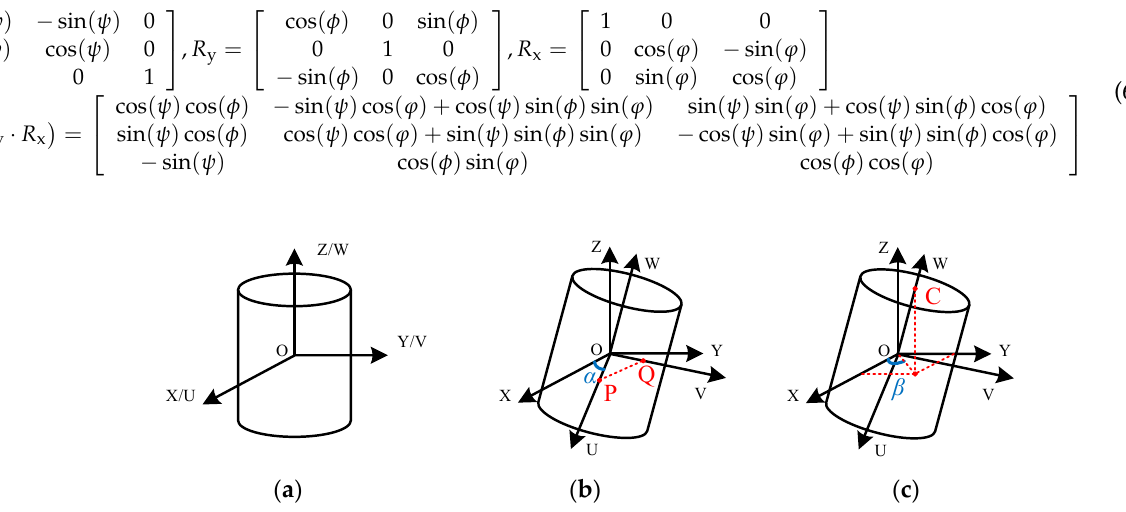
Figure 5. Spatial description of sensing unit. ( a ) Global coordinate system and reference coordinate system; ( b ) Schematics of tilt angle measurement; ( c ) Schematics of azimuth measurement.